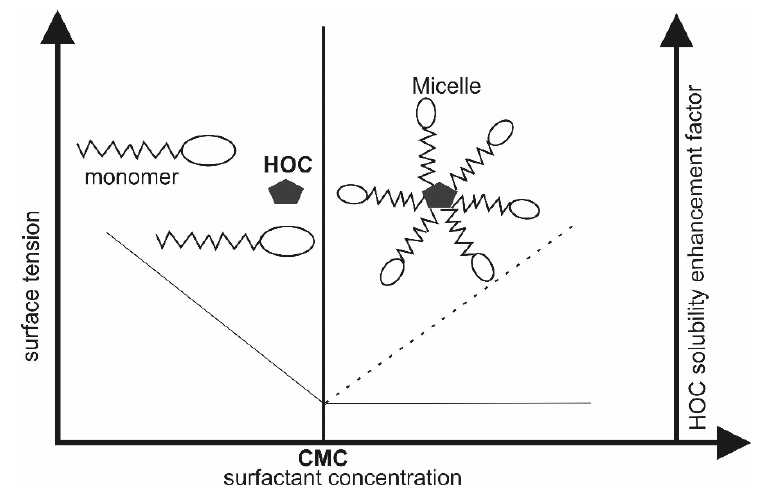
Figure 3. Surface tension and hydrophobic organic compound (HOC) solubility enhancement factor as a function of surfactant concentration. Printed with the permission of [2].